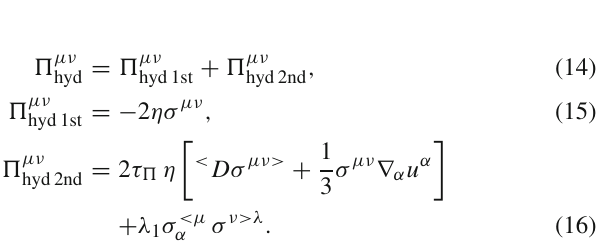
Fig. 2 The local energy density ε( t , r ) in the ( r , t ) -plane, calculated from the transport equation (A54) with longitudinally boost-invariant and azimuthally symmetric initial conditions of Woods–Saxon type (11). The panels scan the only model parameter, the opacity ˆ γ , from the free-streaming limit ( ˆ γ = 0) up to values of ˆ γ sufficiently large